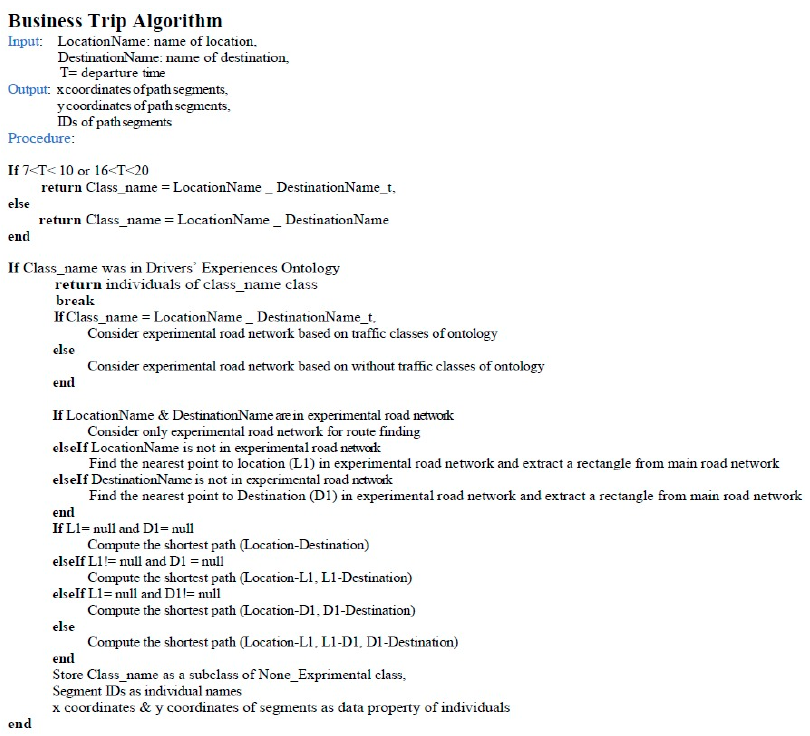
Figure 5. Business trip